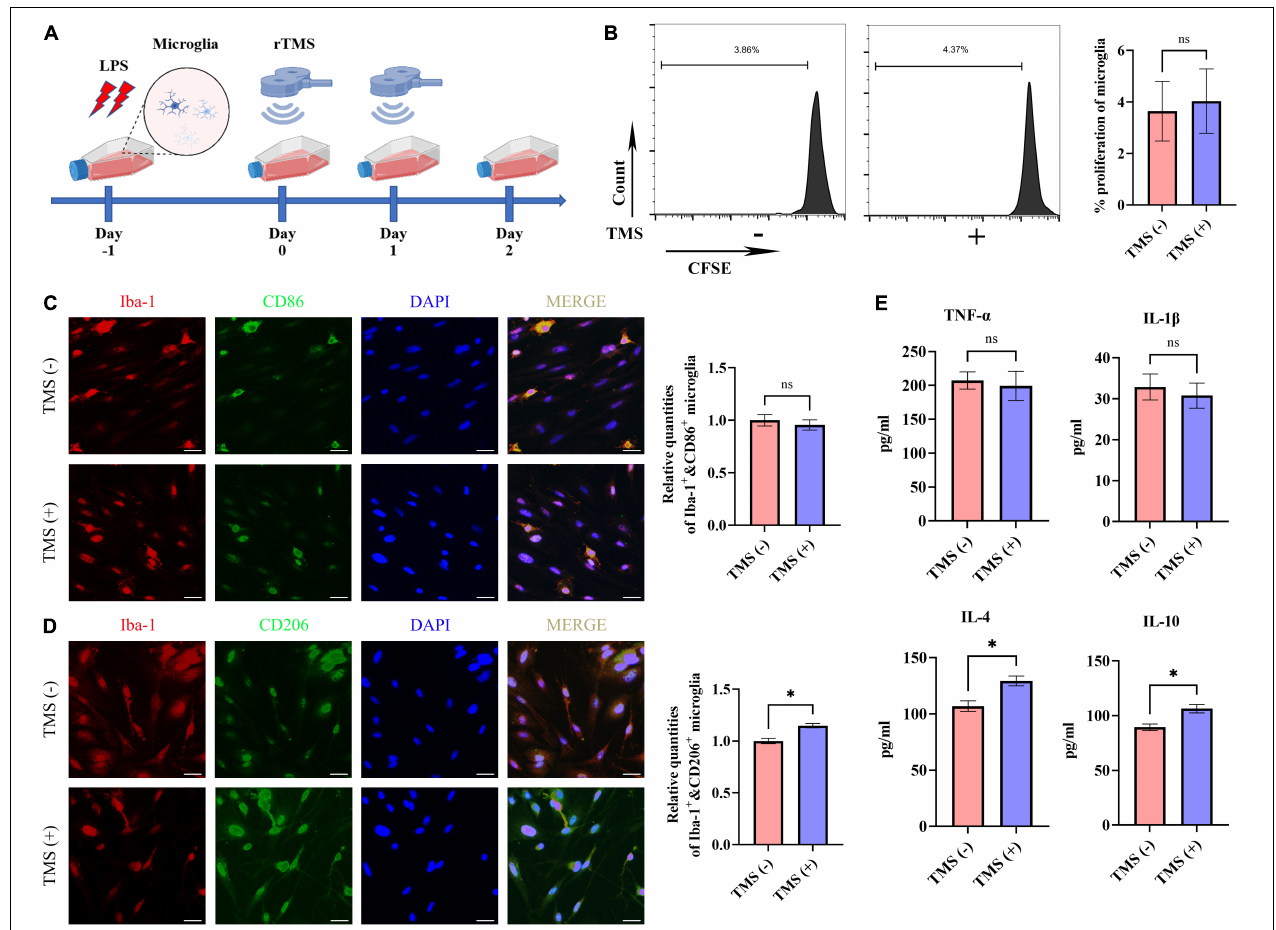
FIGURE 6 | Neuroprotective polarization of microglia activated by lipopolysaccharide (LPS). (A) The experiment timelines of rTMS stimulation for microglia activated by LPS. Microglia were treated with rTMS at 1 day after LPS stimulation. (B) Carboxyfluorescein succinimidyl ester (CFSE) analysis of cell proliferation. Quantitative analysis of Iba-1 + and CD86 + neurotoxic microglia (C) and Iba-1 + and CD206 + neuroprotective microglia (D) in TMS (–) and TMS (+) groups ( n = 3). Quantity of Iba-1 + and CD86 + or Iba-1 + and CD206 + cells in TMS (–) group was normalized as control. (E) The secretion of inflammatory and anti-inflammatory cytokines in TMS (–) and TMS (+) groups ( n = 3). Data are shown as mean ± SEM. Scale bar, 10 µ m, * P < 0.05 and ** P < 0.01, and ns means no